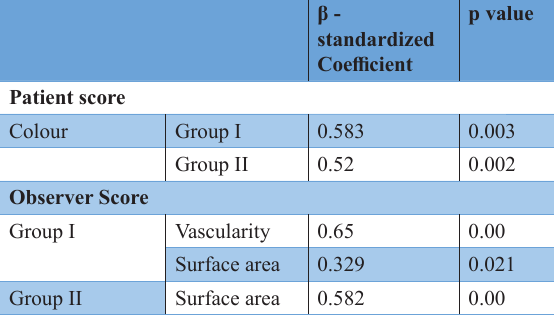
Observer Scar Assessment Scale (OSAS)